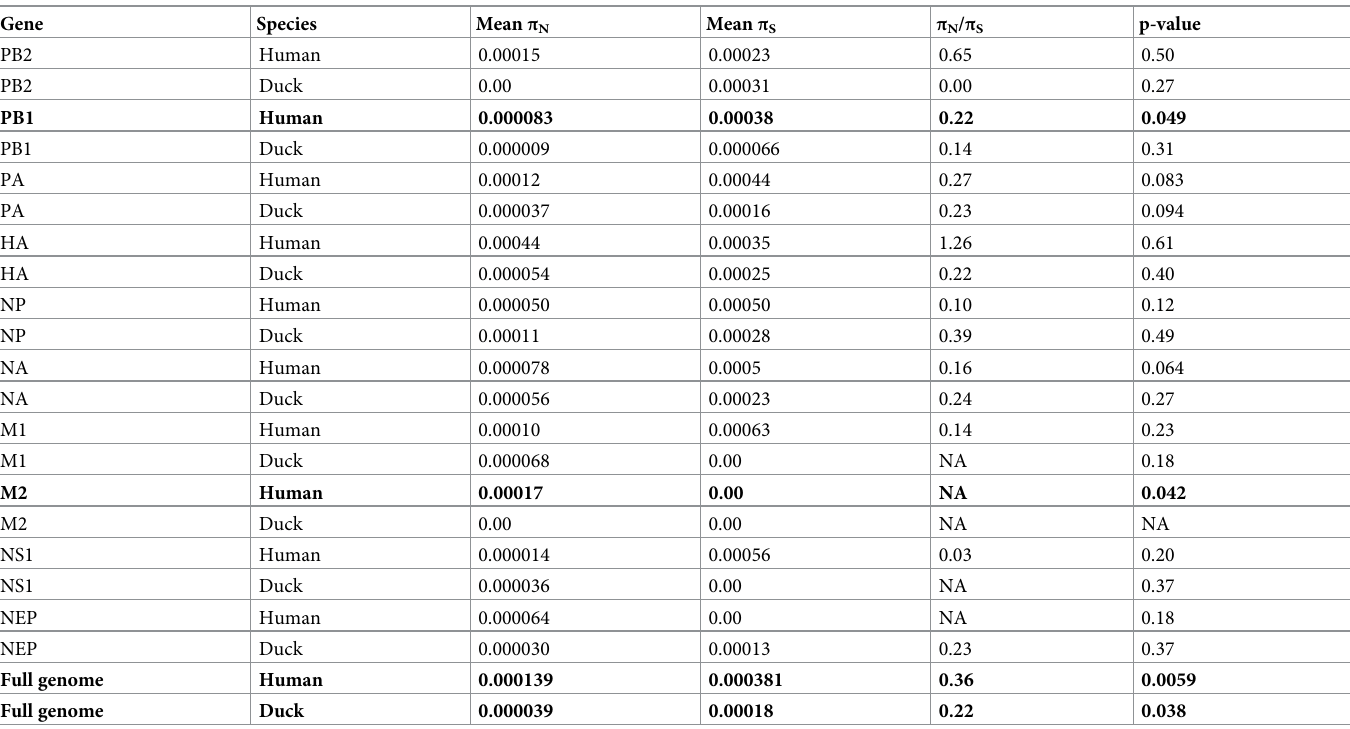
Table 2. Mean π N and π S values per gene.